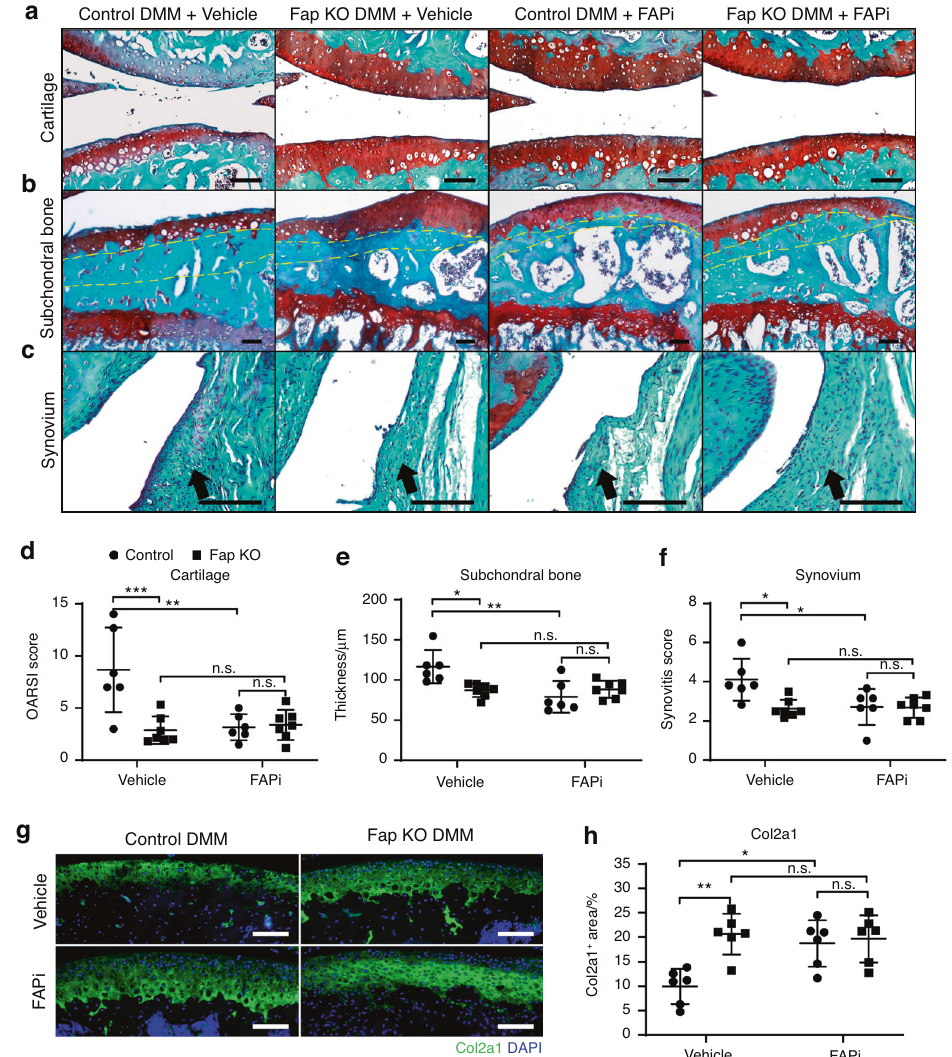
Fig. 2 Fap promotes OA progression in a mouse DMM model. a – c Safranin O/Fast Green staining in control and Fap KO mice treated with FAPi or vehicle after DMM surgery. Weekly intra-articular administration of FAPi (40 μ g/kg body weight) or vehicle (PBS) in 10-week-old mice was started 3 days after the surgery and continued for 8 weeks before paraf fi n sectioning and safranin O/fast green staining of the knee joints. Representative cartilage erosion ( a , top: femur, bottom: tibia), subchondral bone thickening ( b ) and synovitis ( c ) images are shown ( n = 6 – 7 mice per genotype in each treatment group). Yellow dotted lines indicate the subchondral bone plate. Arrows indicate the synovium. Scale bars: 100 μ m. d – f Quanti fi cation of the OARSI score ( d ), subchondral bone thickness ( e ) and synovitis score ( f ). OARSI scores were calculated based on the erosion of the medial tibial plateau cartilage ( a , bottom). Subchondral bone thickness was measured as the mean distance of fi ve evenly distributed measuring points between the lower edge of the articular cartilage and the roof of the cancellous bone. Synovitis scores were calculated by summing the enlargement of the synovial lining cell layer, density of the resident cells and in fl ammatory in fi ltration. g , h Immunostaining of Col II in the knee joints ( g ) with quanti fi cations ( h ) ( n = 6 mice per genotype in each treatment group). DAPI staining indicates the nucleus. Scale bars: 100 μ m. The statistical signi fi cance was assessed using two-way ANOVAs with Sidak ’ s multiple comparison tests. Data are presented as the mean ± SD (* P < 0.05, ** P < 0.01, *** P < stimulated the cells with IL-1 β to mimic OA pathogenesis. 57 – 59 the genetic deletion or pharmacological inhibition of Fap signi fi cantly ameliorated OA progression. Consistent with a previous study, 60 qPCR analysis in control chondrocytes showed signi fi cantly decreased Acan and Col2a1 Fap does not regulate chondrocyte function in a cell-autonomous mRNA levels and signi fi cantly increased Mmp3 mRNA levels after manner IL-1 β stimulation (Fig. S4a – c). Compared to control chondrocytes, Fap is expressed in perichondral mesenchymal cells surrounding Fap KO chondrocytes showed similar Acan , Col2a1 and Mmp3 the cartilage primordia during mouse embryonic development. 56 expression before and after IL-1 β stimulation (Fig. S4a – c). Consistent with this, western blot analysis showed signi fi cantly Consistent with this, Fap was mainly detected in the synovium, decreased Acan and Col2a1 protein levels and signi fi cantly but not articular cartilage, of normal and OA knee joints in adult increased Mmp3 protein levels after IL-1 β stimulation (Fig. S4d, mice (Fig. 1d). To test whether Fap regulates chondrocyte function e), with no signi fi cant differences between Fap KO and control in a cell-autonomous manner, we cultured primary articular chondrocytes (Supplementary Fig. 4d, e). chondrocytes from Fap KO or wild-type newborn mice and